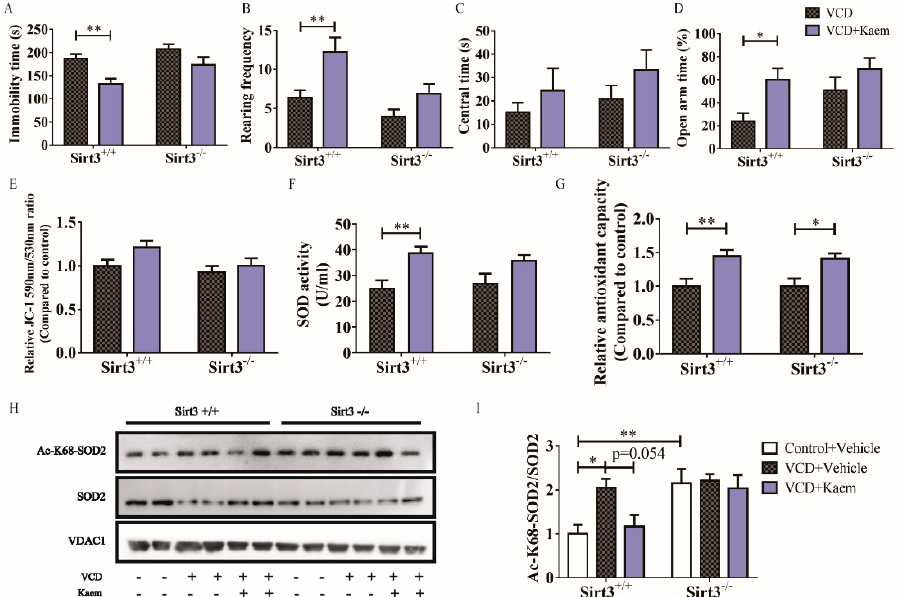
Figure 4. Sirt3 depletion increases SOD2 acetylation and partially prevents antidepressant-, anxiolytic-like effects as well as antioxidant effects. ( A ). Immobility time in FST. ( B , C ) Rearing frequency ( B ) and time spent in the central area ( C ) in OFT. ( D ) Percentage of time spent in the open arms in EPM. ( E – G ) the membrane potential and antioxidant activity of mitochondria isolated from mouse hippocampal tissue of all experiment groups. Statistic results of mitochondrial membrane potential ( E ) were determined by the ratio between the fluorescence intensity at 590 nm (red fluorescence of polymer) and 530 nm (green fluorescence of monomer) after JC-1 staining. The antioxidant activity of mitochondria was reflected by the statistic result of SOD activity ( F ) and normalized statistic results of total antioxidant capability ( G ). ( H ) Representative immunoblot of protein levels of Ac-K68-SOD2 and SOD2 in the hippocampal mitochondria from mice in six experiment groups. ( I ) SOD2-K68 acetylation was normalized by SOD2. n = 12 per group in ( A – G ), n = 4 per group in ( I ) Data are represented as mean ± SEM. Two-way ANOVA analysis with Sidak’s multiple comparisons test or Mann–Whitney test: * p < 0.05, ** p < 0.01.